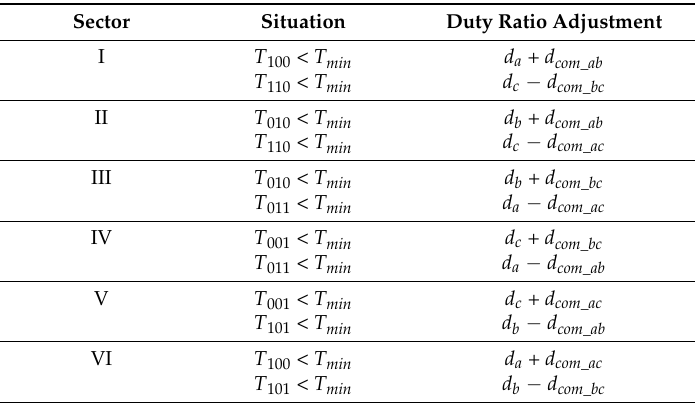
Table 5. Duty ratio adjustment in each